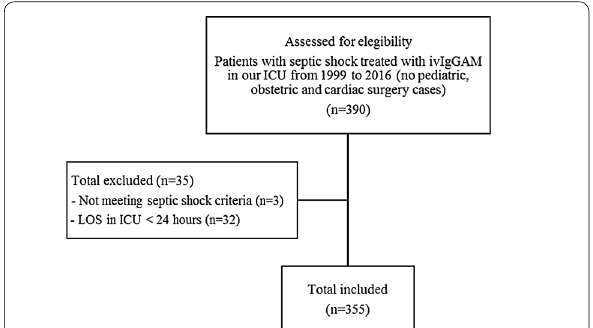
Fig. 1 Flowchart with inclusion and exclusion criteria. ivIgGAM, intravenous IgM- and IgA-enriched immunoglobulins; ICU intensive care unit; LOS length of